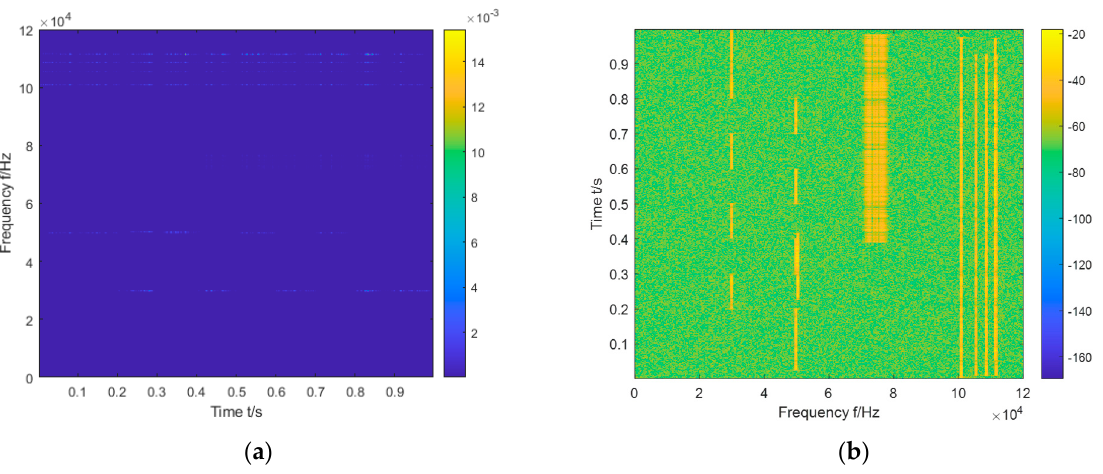
Figure 3. Image ( a ) is the original time-frequency image, and image ( b ) is the normalized image.